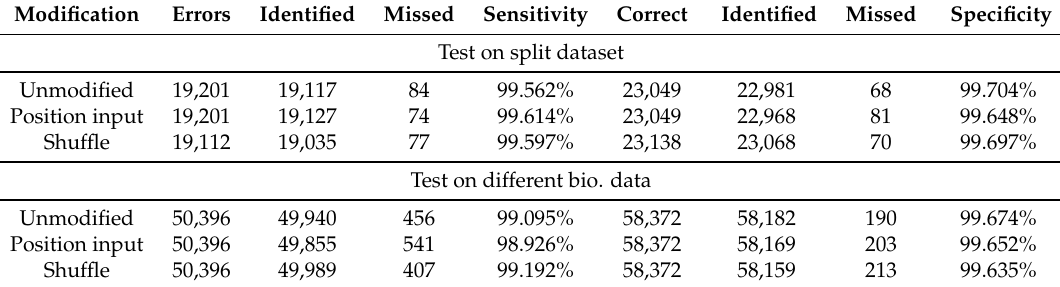
Table 4. Change of accuracy of error classification with other modifications of the ANN